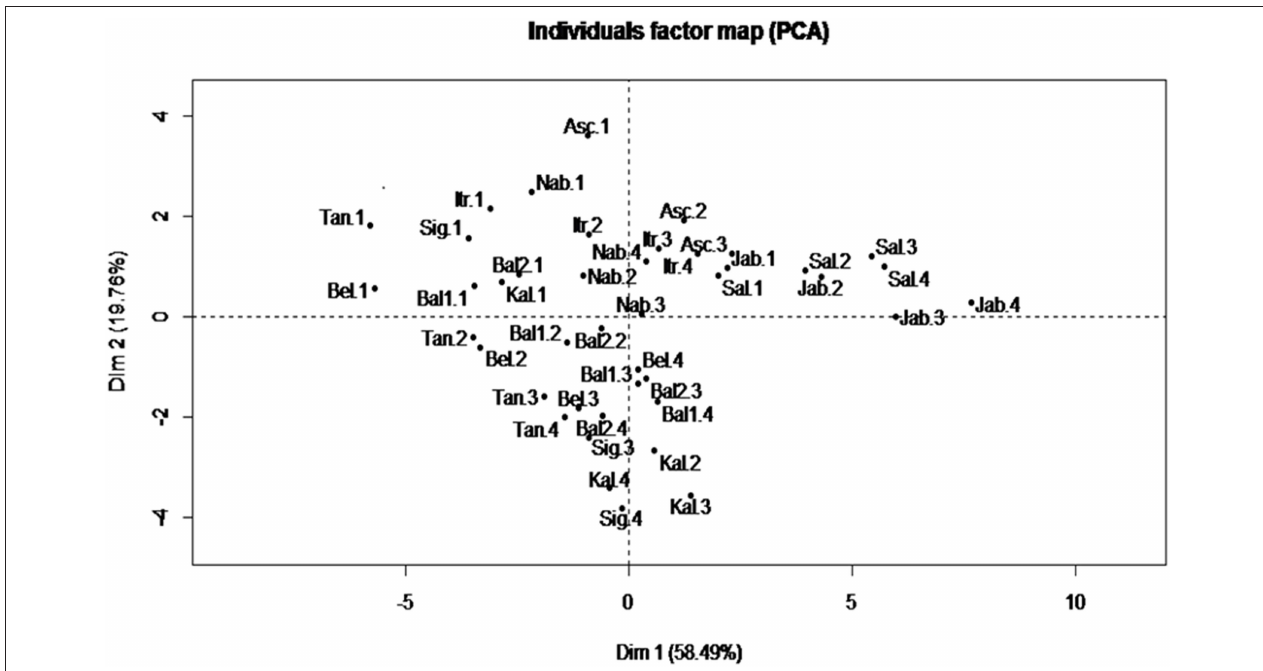
FIGURE 2 | Biplot of principal components 1 and 2 based on fatty acid profile components recorded for each variety at different ripening indexes. Asc, “Ascolana Tenera;” Bal1, “Baladi 1;” Bal2, “Baladi 2;” Bel, “Bella di Cerignola;” Itr, “Itrana;” Jab, “Jabaa;” Kal, “Kalamata;” Nab, “Nabali;” Sal, “Salonenque;” Sig, “Sigoise;” Tan, “Tanche.” 1, 2, 3, and 4 are the different harvesting